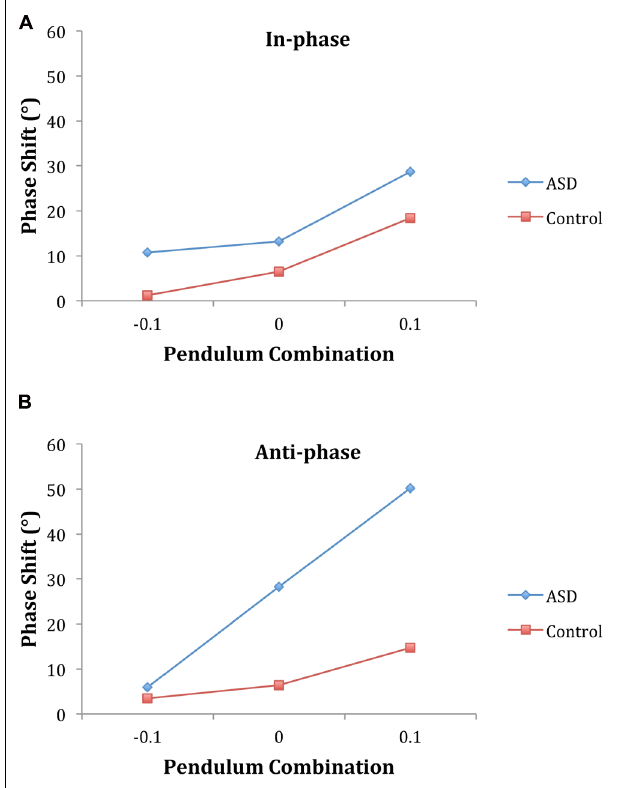
FIGURE 4 | Phase shift supports the dynamical model predictions for intentional coordination. The adolescent led less when the parent had the larger pendulum and led the most when they had the larger pendulum. This was true for both groups and was evident for both in-phase (A) and anti-phase (B) coordination. The phase shift was greater overall for the group with ASD than the controls and the difference between groups was more pronounced for anti-phase than in-phase. (Note: Convention comparable with Varlet et al., 2012; − 0.1 indicates parent should lead, + 0.1 indicates child should